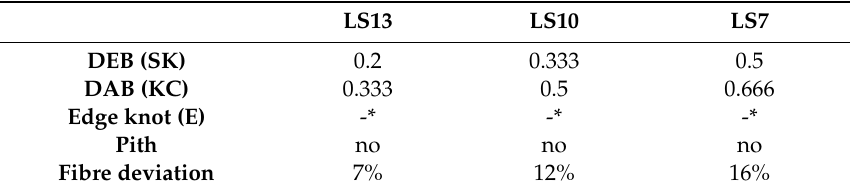
Table 2. Boundary values for grading of hardwood lamellas to visual grades (LS7 to LS13) after DIN 4074-5